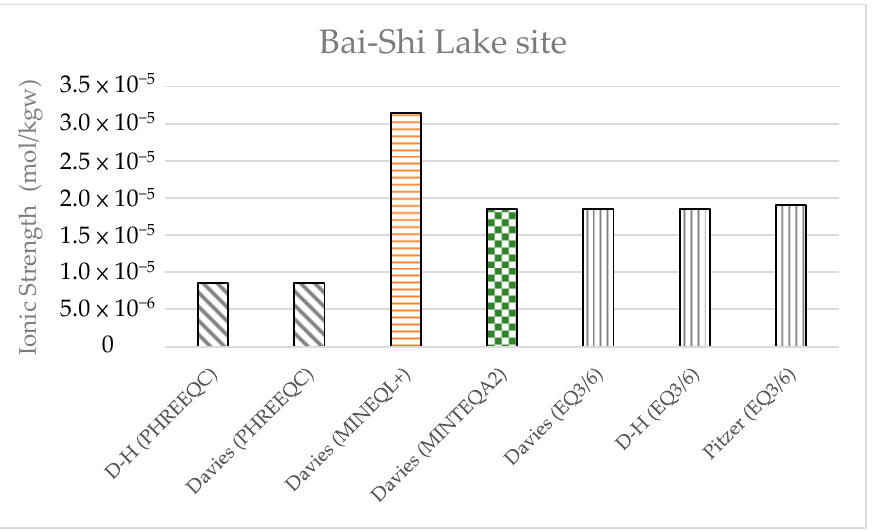
Figure 18. Activity coefficients of the major species for the four models with different activity coef- ficient equations at the Shiau-Chiou site.